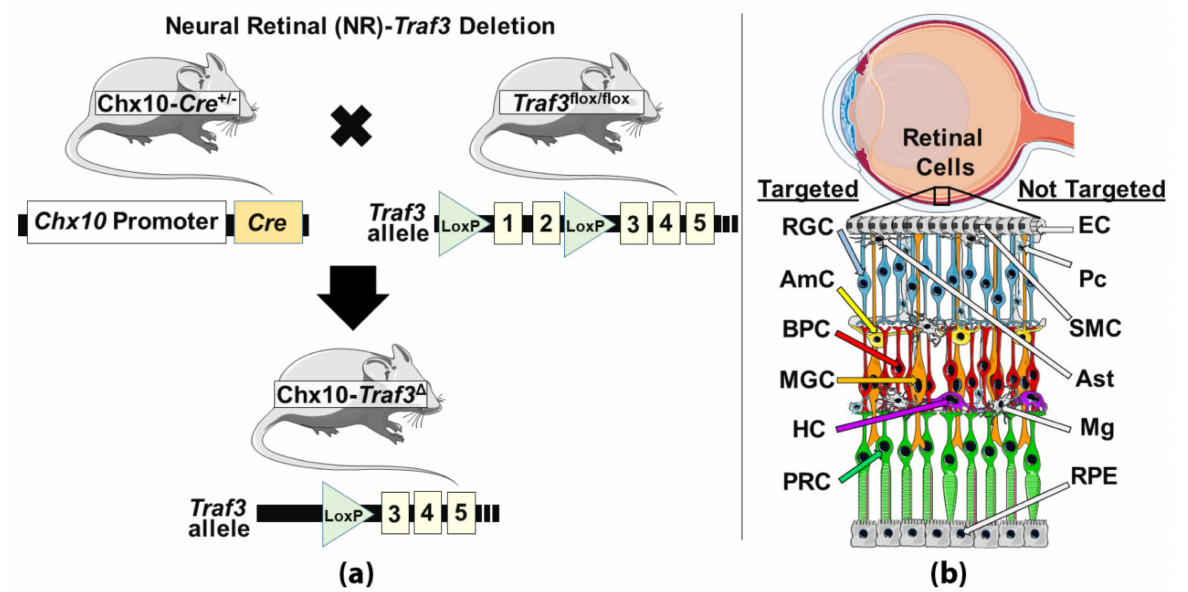
Figure 1. Schematic diagram showing neural retinal (NR)-specific genetic deletion of Traf3 in the Chx10 -Cre/Traf3 flox/flox (NR- Traf3 KO) mouse model. ( a ) Breeding strategy for NR-specific Traf3 depletion. ( b ) Retinal tissue diagram outlining resident retinal cell populations targeted (and not targeted) for Traf3 deletion using the NR- Traf3 KO model. Targeted: RGC, retinal ganglion cell; AmC, amacrine cell; BPC, bipolar cell; MGC, Müller glial cell; HC, horizontal cell; PRC, photoreceptor cell. Not targeted: EC, endothelial cell; Pc, pericyte; SMC, smooth muscle cell; Ast, astrocyte; Mg, microglia; RPE, retinal pigment